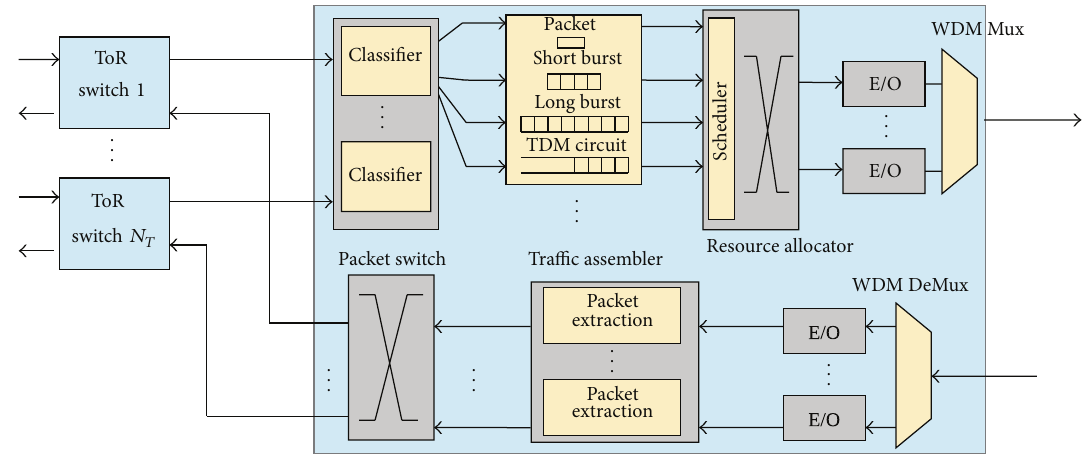
Figure 3: HOS edge node